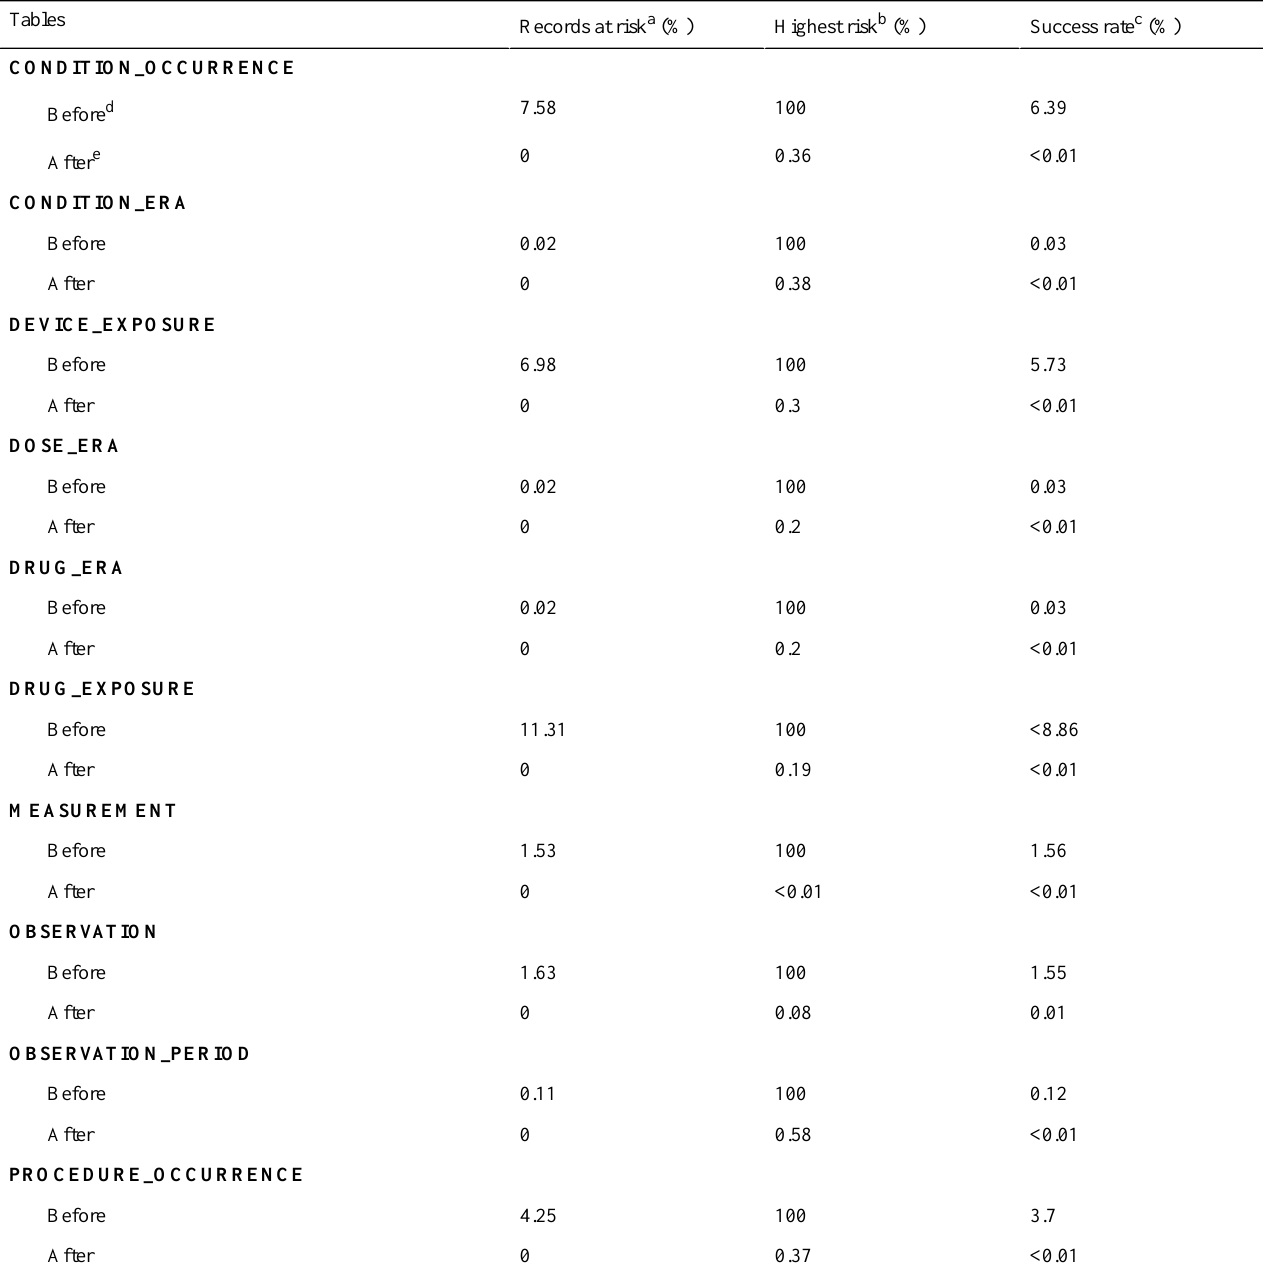
Table 4. Re-identification risks before and after source_value anonymization (l-diversity, l =